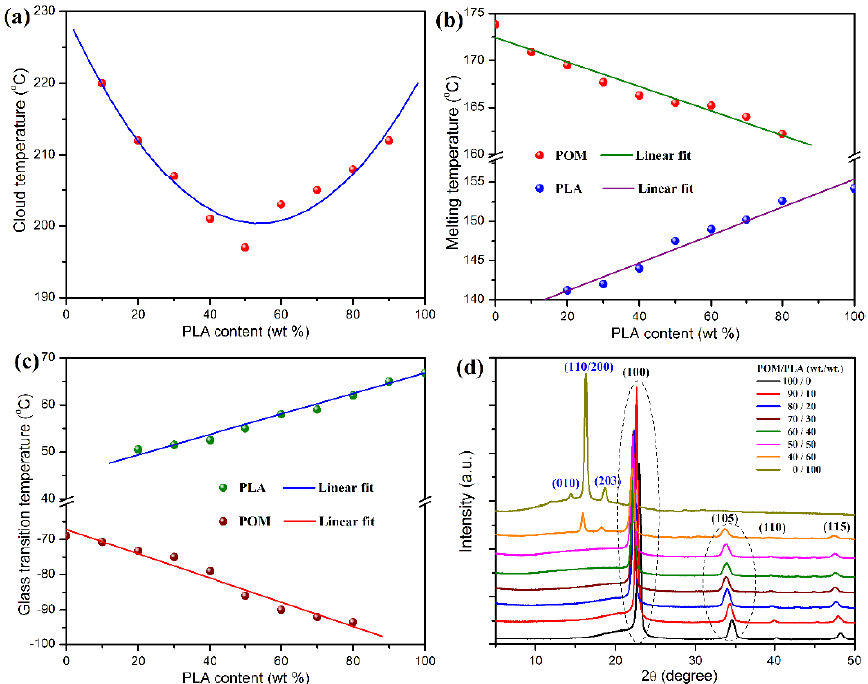
Figure 1. ( a ) Cloud temperatures, ( b ) melting temperatures, ( c ) glass transition temperatures, and ( d ) XRD patterns of polyoxymethylene/polylactide (POM/PLA) blends at different mass ratios.